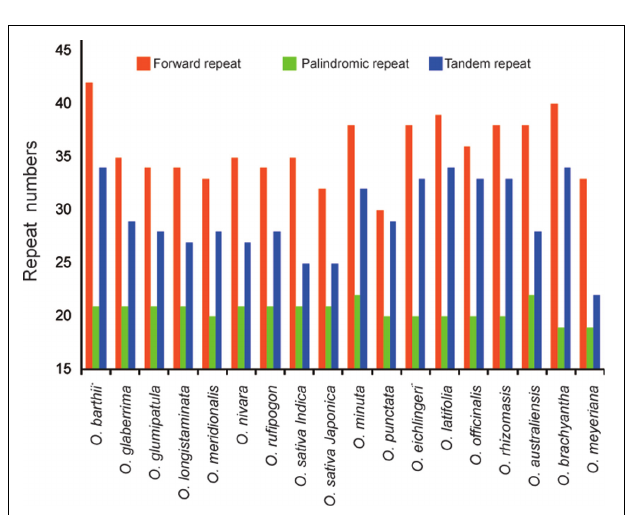
FIGURE 3 | Analysis of repeated sequences in 18 Oryza chloroplast